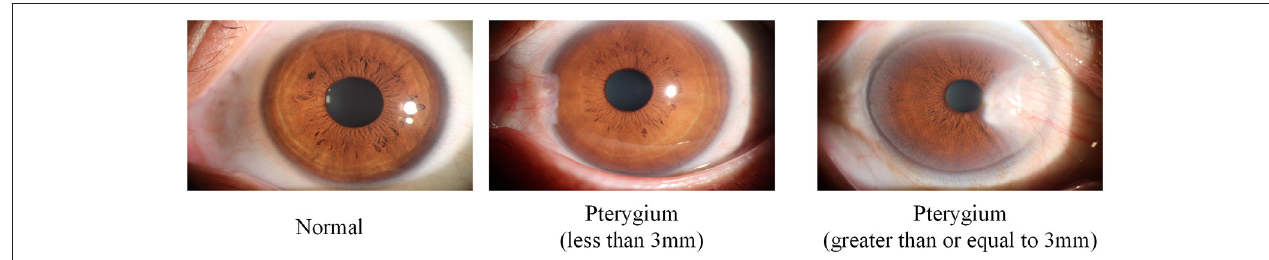
FIGURE 1 | Three types of anterior segment images in the